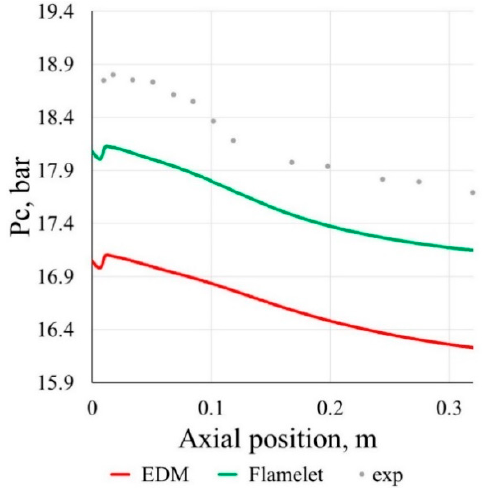
Figure 5. Pressure axial distribution.